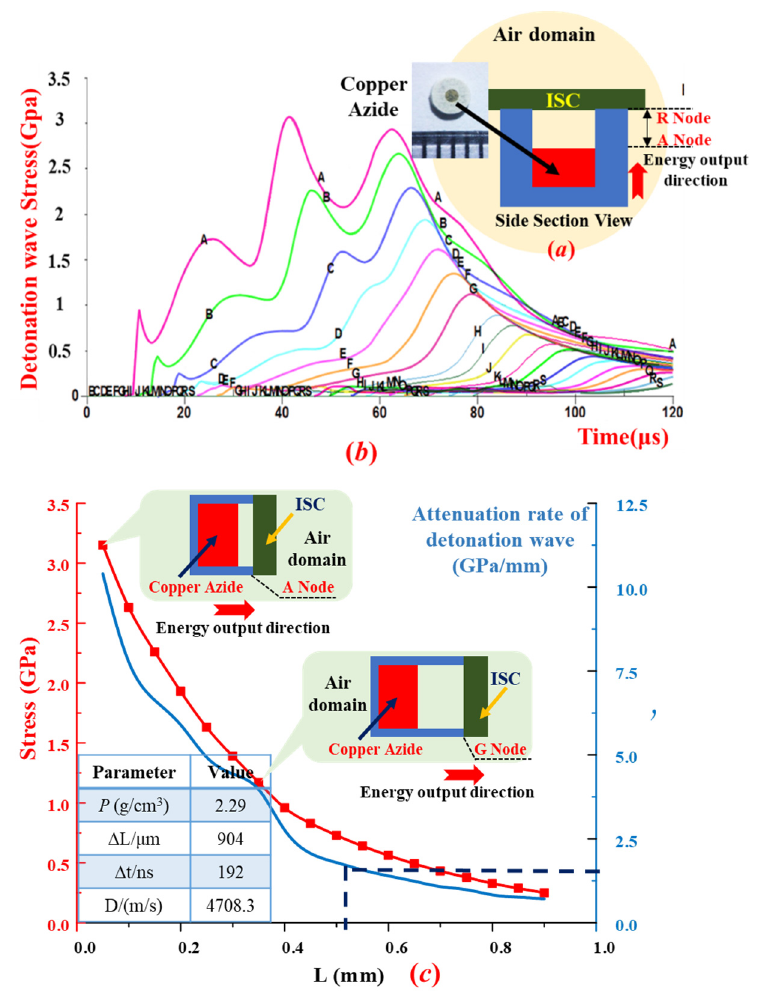
Figure 6. Stress wave of copper azide energy transfer over time. ( a ) The model of Psd module. ( b )detonation wave stress variation curve by time in air domain. ( c ) The relationship between detonation wave stress, attenuation rate under different air gap.